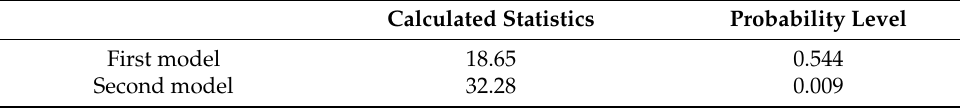
Table 9. Hausman test results.